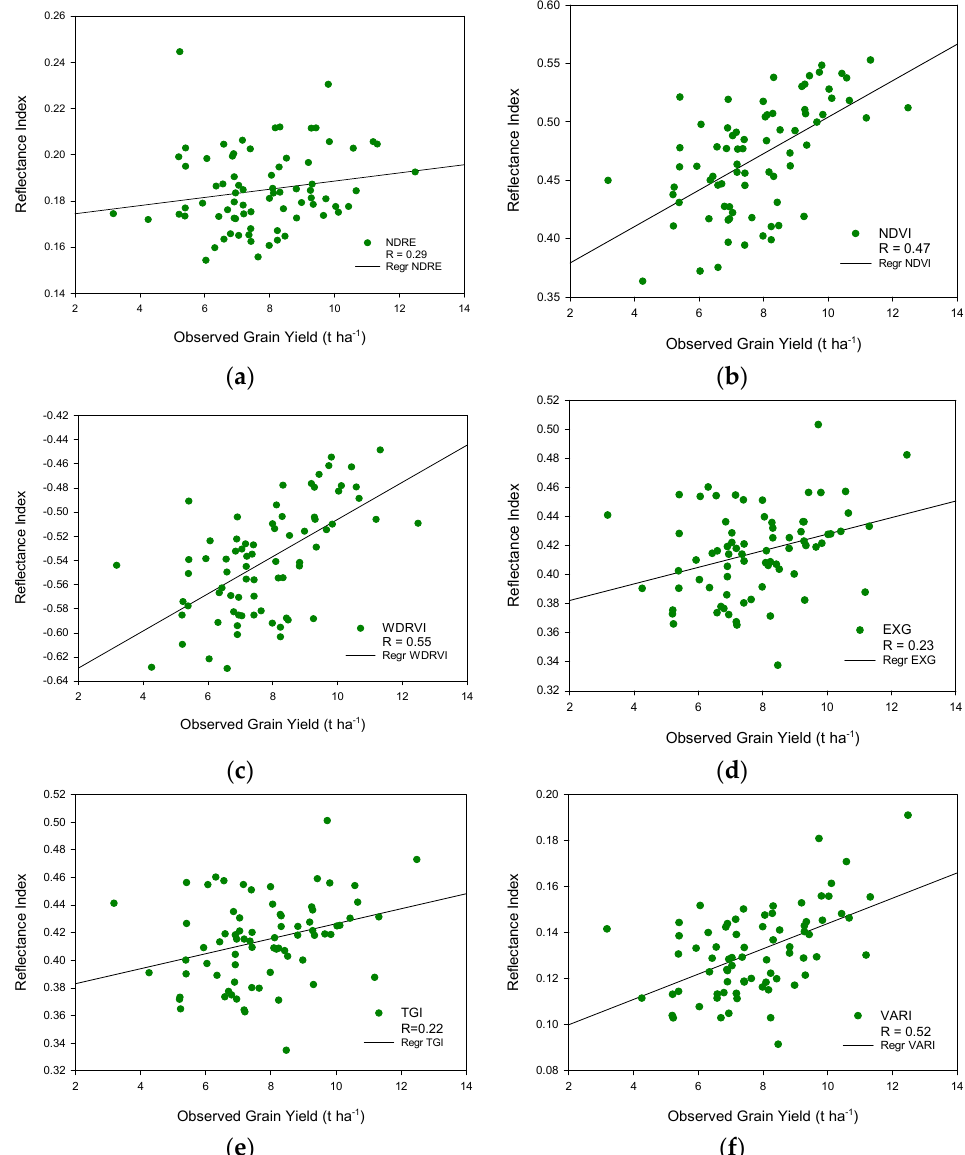
Figure 5. Correlation of vegetation indices and yield at 47 DAS. ( a ) Normalized di ff erence red edge index (NDRE); ( b ) normalized di ff erence vegetation index (NDVI); ( c ) wide dynamic range vegetation index (WDRVI); ( d ) excess green (ExG); ( e ) triangular greenness index (TGI); ( f ) visible atmospherically resistant index (VARI).